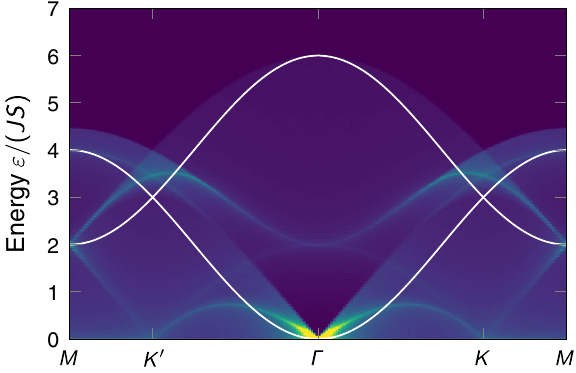
FIG. 12. Collision density of states in honeycomb ferromag- nets. At B ¼ 0 , the harmonic single-particle energies [white lines; cf. Eq. (12)] overlap with the collision density of states [color plot; cf. Eq. (41)]. Dark blue (yellow) color indicates zero (maximal) collision density of states. For increasing fields, the single-particle energies are shifted upwards in energy by B , while the collision continuum is fixed. Hence, for large enough fields, the single-particle bands are shifted past the continuum. In particular, the Dirac cones at the K and K 0 points leave the JS , similar to the two-magnon density of continuum at B ¼ B c ¼ states in Fig.